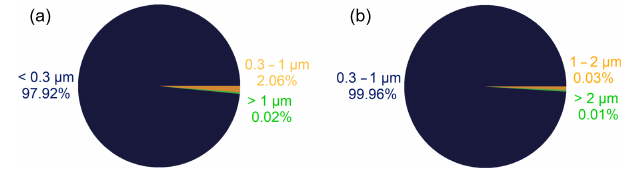
Figure C3. The percentage of 200 (a) and 400nm (b) size-selected mCASTblack bare soot particles in three optical size ranges mea- sured by the OPC operating in different counting channels, includ- ing 0.3, 1 and 2µm.